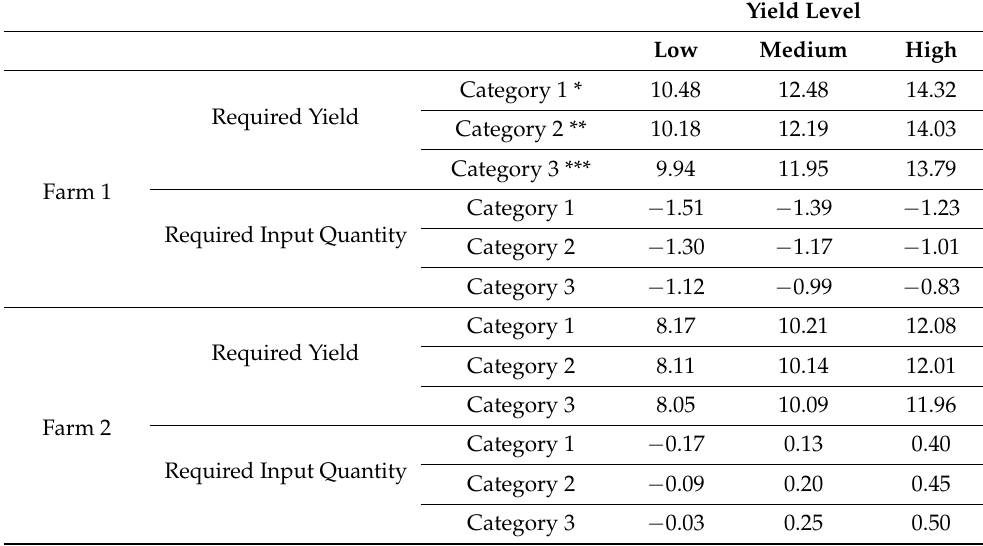
Table A4. Results of sensitivity analysis—required shifts in product functions on Farms